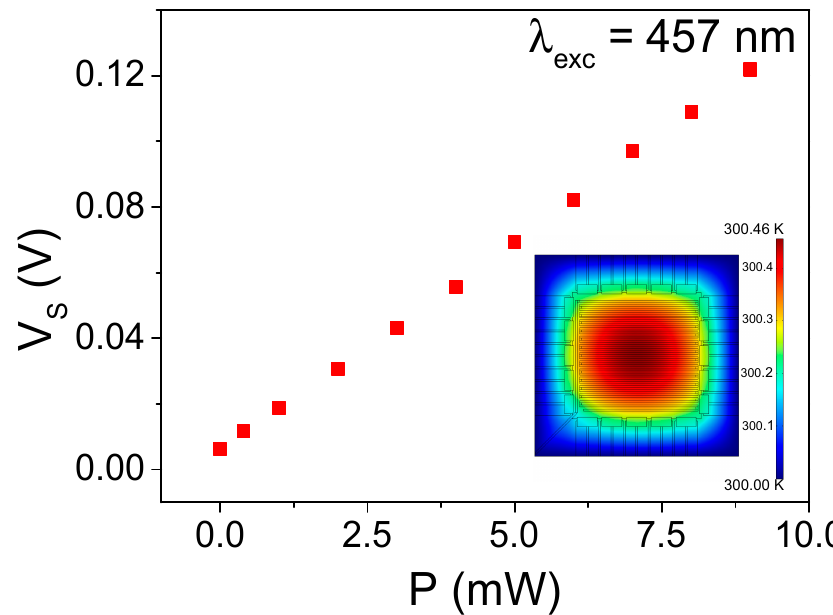
Figure 2. Plot of the voltage at open circuit as a function of laser power. The inset plot shows the temperature profiles simulated by FEM.